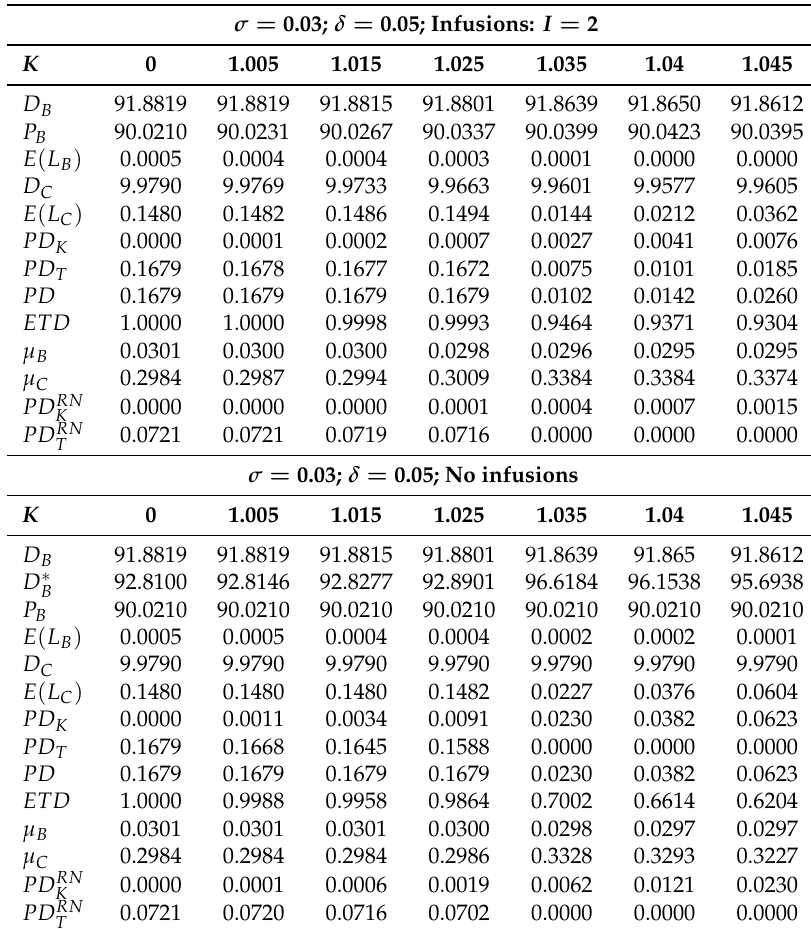
Table 7. SIV outcomes with infusions when risk control K is varied. The fire sale discount is fixed at δ = 0.05 and the face value of debt is taken to be the same as the identical case without infusions. Compare this table (upper panel) with the results from Table 4 (included now in the lower panel). The required infusion here is I = 2, whereas in Table 4 no infusions are